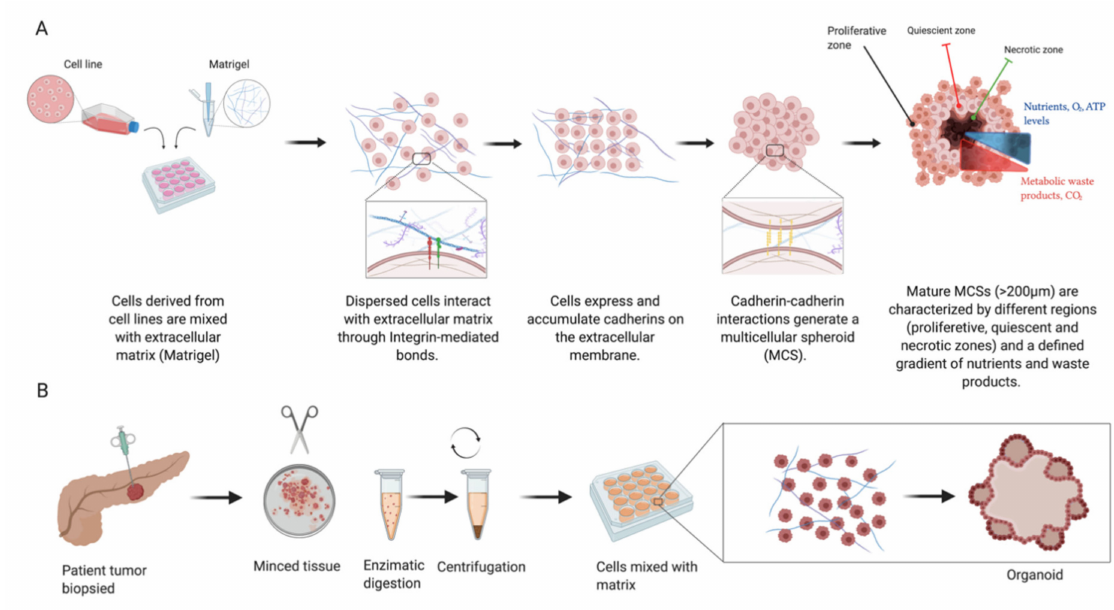
Figure 2. Multicellular spheroids (MCSs) are derived from cell lines or patient-derived xenograft (PDX) cells ( A ). Increased cellular expression of cadherins and their intercellular cadherin–cadherin interactions lead to spheroid compaction. Mature spheroids show a concentric organisation into multilayered structures leading to nutrient gradient formation, resulting in insu ffi cient transport towards their core as well as elimination of waste products. Organoids ( B ) are derived from primary tissue stem cells and their culture gives rise to structures mimicking the original tissue architecture. (Illustration created with